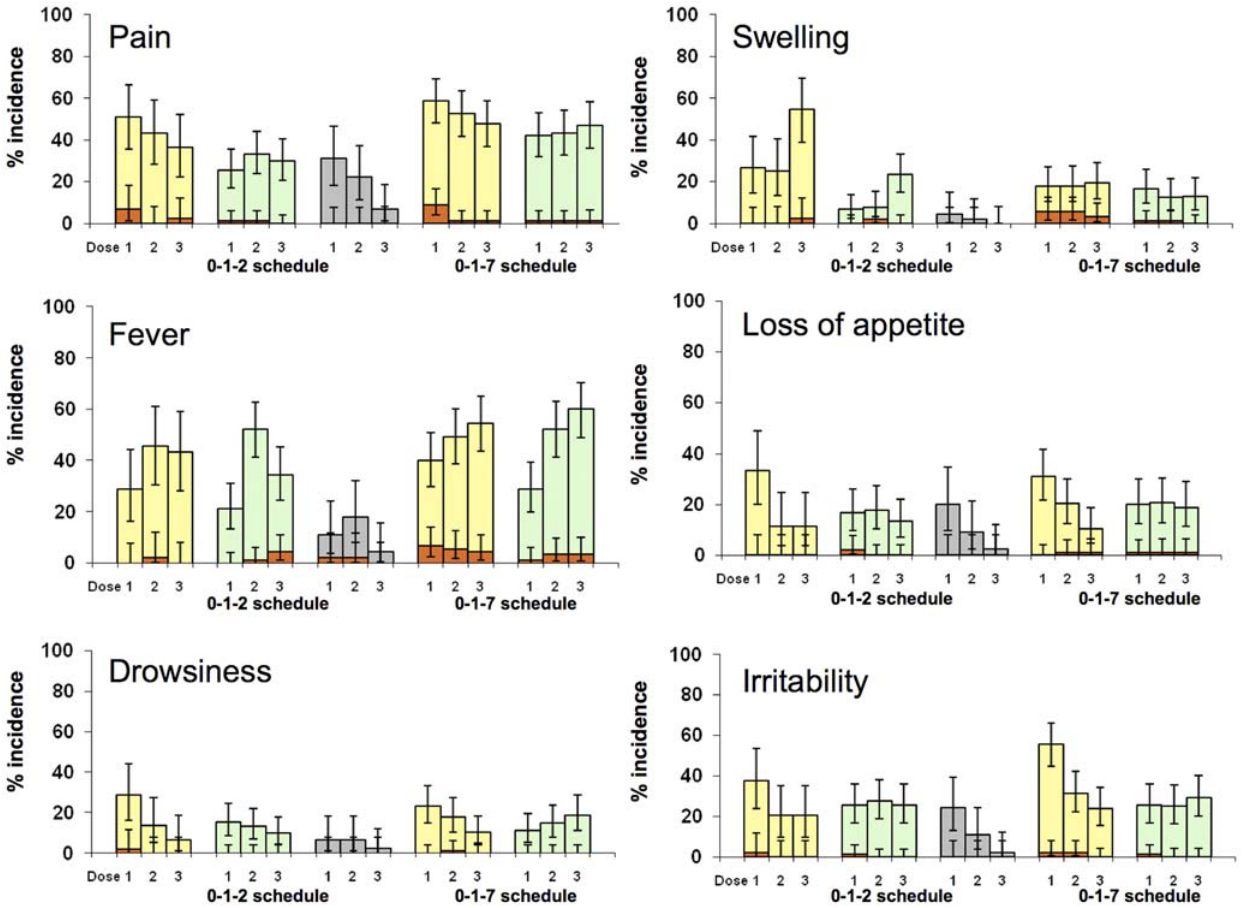
Figure 2. Percentage of solicited events post dose 1, 2 and 3 (Total Vaccinated Cohort). Yellow=RTS,S/AS02 D ; Green=RTS,S/AS01 E ; Grey=Rabies vaccine; Orange=Grade 3 Bars represent 95% confidence intervals.